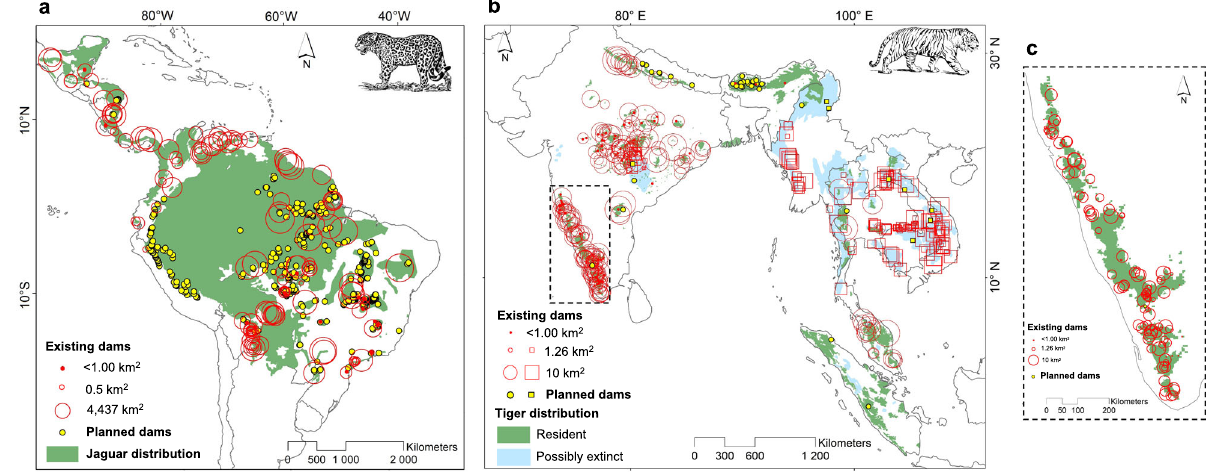
Fig. 1 Distribution of existing and planned hydropower dams intersecting jaguar and tiger distributions. a Hydropower dams intersecting the distribution of jaguars. b Dams across the distribution of tigers. Existing and planned dams are represented by red open circles and yellow dots, respectively, except in areas where tigers are possibly extinct, where dams are represented by squares . Circle/square size is proportional to reservoir area (log 10 ). c Inset showing Western Ghats in